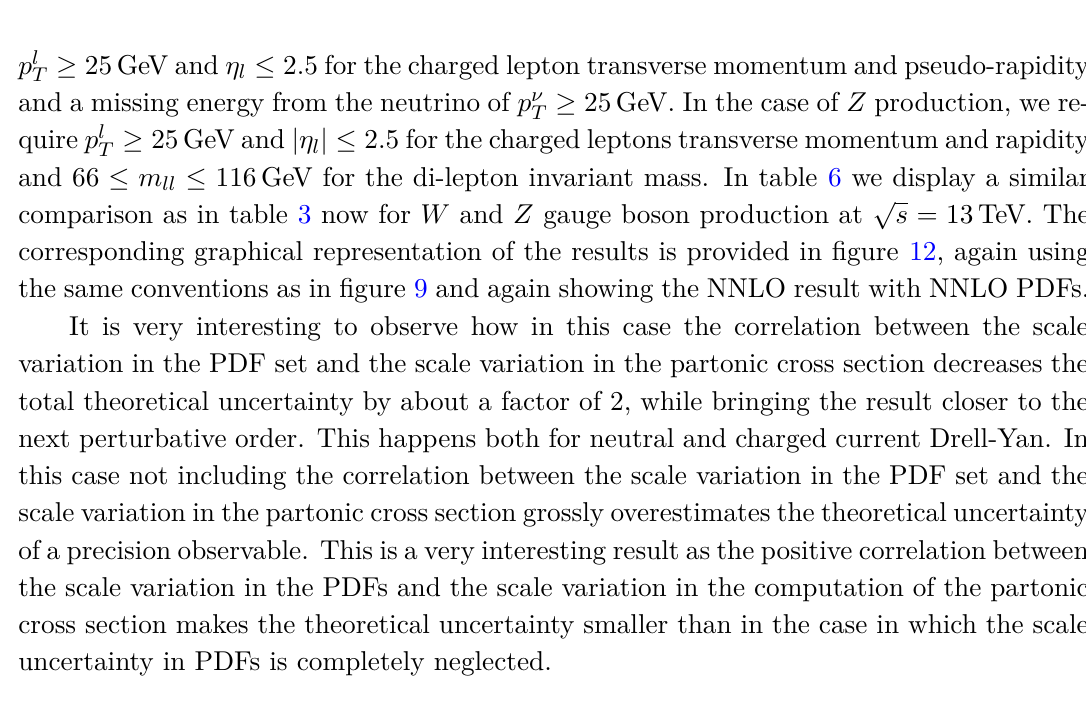
Table 6 . Same as table 3 for the NLO total cross sections for vector boson production cross section √ NLO for s = 13 TeV. The NNLO result are 779.7 pb, 4751.6 pb and 3605.2 pb for Z , W + , W − production